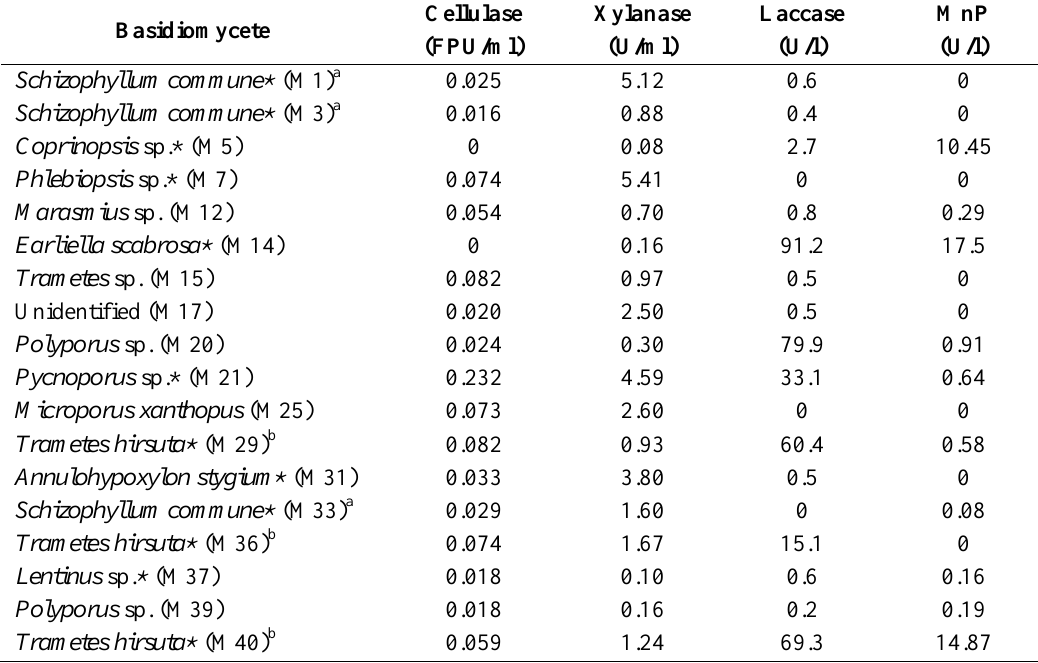
Table 1: Identities and enzyme activities of the basidiomycetes collected and grown in